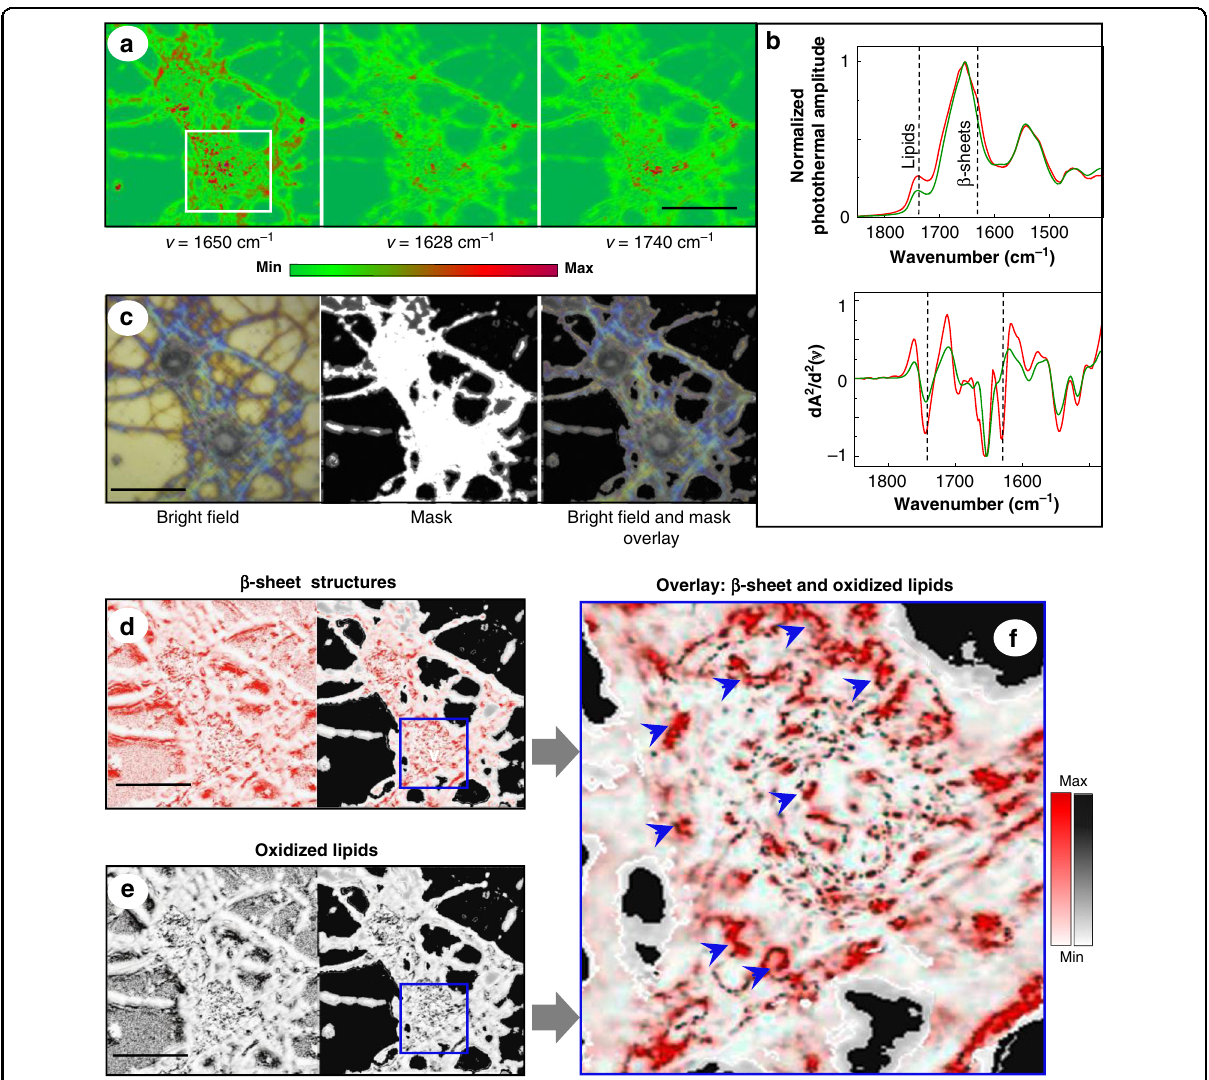
Fig. 2 Co-localization of β -sheet structures and lipid oxidation in cultured primary neurons, a cellular model of AD. Cultured APP-KO neurons were incubated with 5 × 10 − 6 M A β (1 – 42) for 30 min. a O-PTIR maps acquired at frequencies 1650, 1628, and 1740 cm – 1 . Square indicates zoom-in area shown in ( f ). b Averaged and normalized O-PTIR spectra and their normalized second derivatives recorded from the neurons treated with A β (red) and untreated neurons (green). The locations for red spectra are shown in ( f ). Dashed lines indicate the band positions characteristic for β -sheet structures (1628 cm – 1 ) and oxidized lipids (1740 cm – 1 ). N = 3 cells per APP-KO embryo, from a total of 3 embryos. c Bright- fi eld image of APP- KO primary neurons, image mask, and overlay of a bright- fi eld image with the mask. d β -sheet map: a ratio map was derived from the image acquired at 1628 cm – 1 and divided by the image acquired at 1650 cm – 1 . e Lipid oxidation map: A ratio map derived from the image acquired at 1740 cm − 1 and divided by the image acquired at 1650 cm – 1 . f Digital zoom-in image of the area indicated by a square in ( d ) and ( e ) as an overlay of (red dots) and oxidized lipids (gray dots). Arrows indicate example positions where spectra were taken. Colored bars show the intensity of photothermal amplitude, ranging from 0, set as a threshold, to the maximum. Scale bars are 20